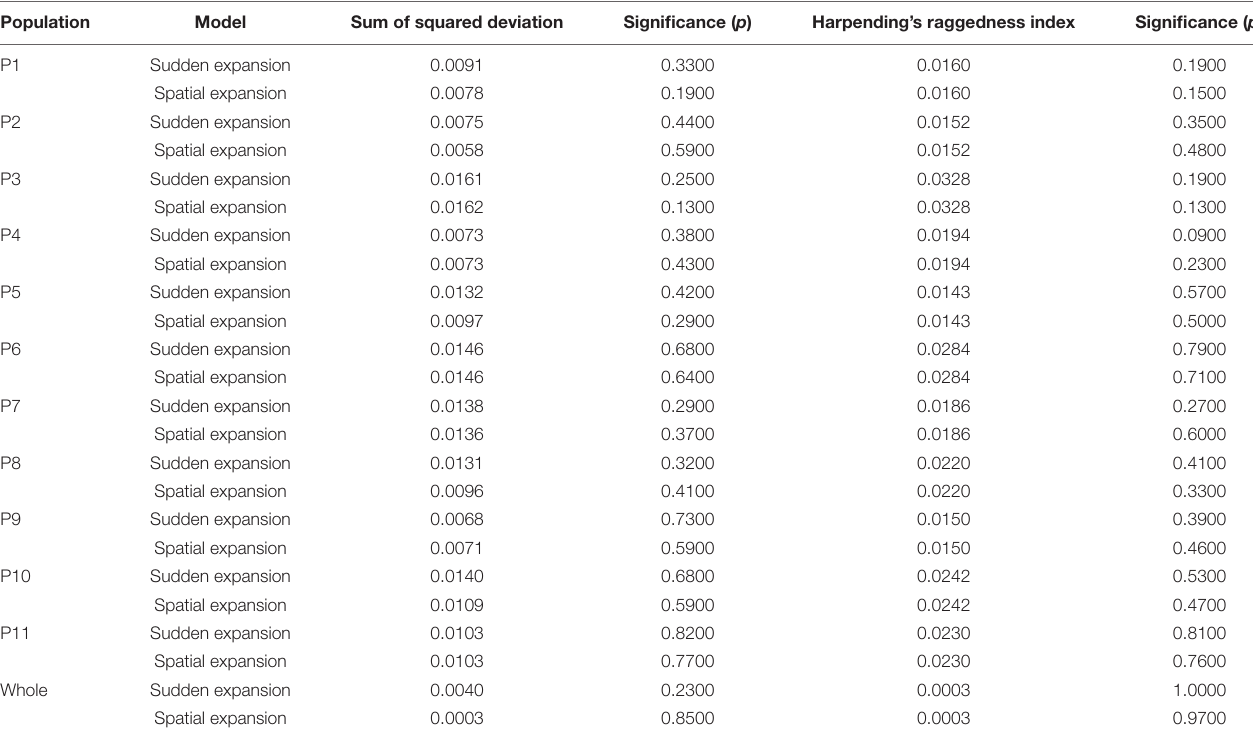
TABLE 7 | Mismatch distribution and the corresponding p -values for the entire dataset of Aphis aurantii based on the concatenated cox1 and cytb genes.